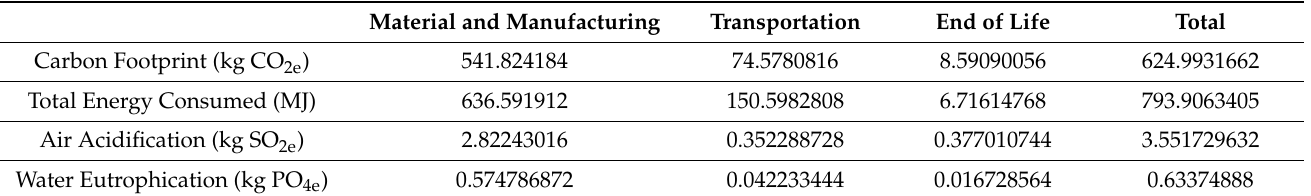
Table 5. Presentation of emissions obtained via LCA analysis for the analysed object for sheep wool with a thickness of 10 cm.